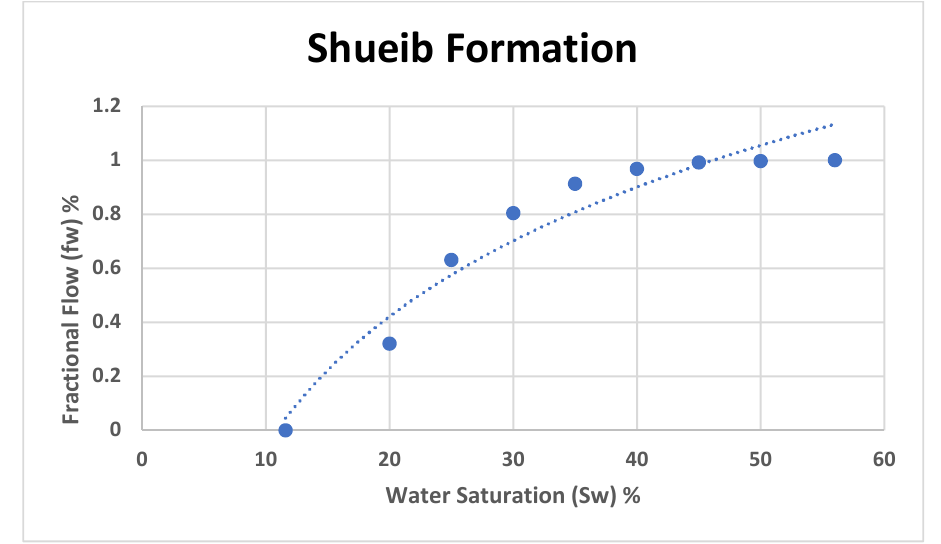
Figure 10. Fractional flow curve for the displacement of oil by water.